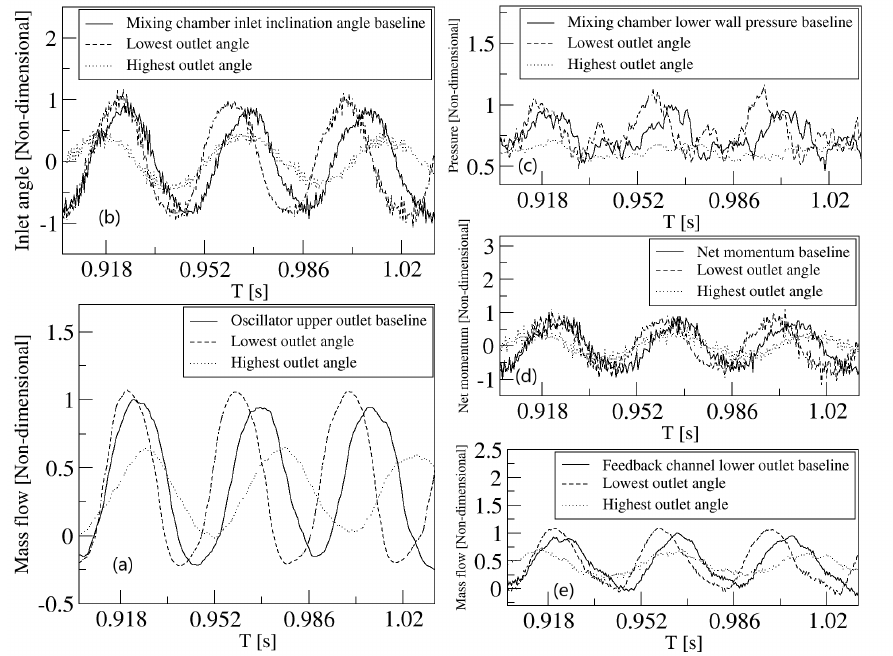
Figure 12. Dynamic effects of the (MC) outlet angle modification on the main flow parameters, Reynolds number 16034. Each graph presents three non-dimensional curves characterizing results from the baseline, the lowest and highest outlet angle cases, and as a function of the dimensional time. In figure ( a ) the mass flow across the upper oscillator outlet is presented. Figure ( b ) introduces the temporal variation of the (MC) inlet inclination angle. Figures ( c ) presents the pressure at the (MC) lower inclined wall. The net momentum acting on the lateral sides of the main jet is presented in figure ( d ). Figure ( e ) characterizes the mass flow at the lower feedback channel